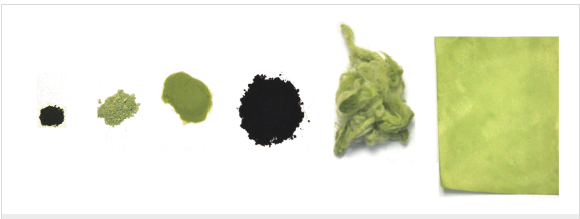
Figure 4: Presentation of various Ru-based catalysts. From the left: 20 mg of Gre-II powder, 20 mg of 8 as fine powder, 20 mg of 8 supported on 380 mg of silica gel, 20 mg of 8 supported on 380 mg of activated carbon, 20 mg of 8 supported on 380 mg of cotton-viscose wool, 20 mg of 8 supported on 380 mg of filter paper (6 × 8 cm).